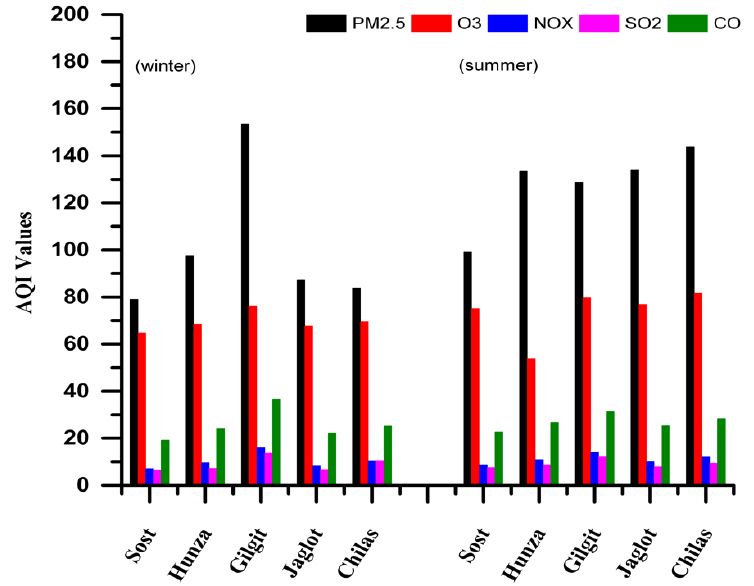
Figure 8. Comparative analysis of AQI values for selected analytes at all locations.